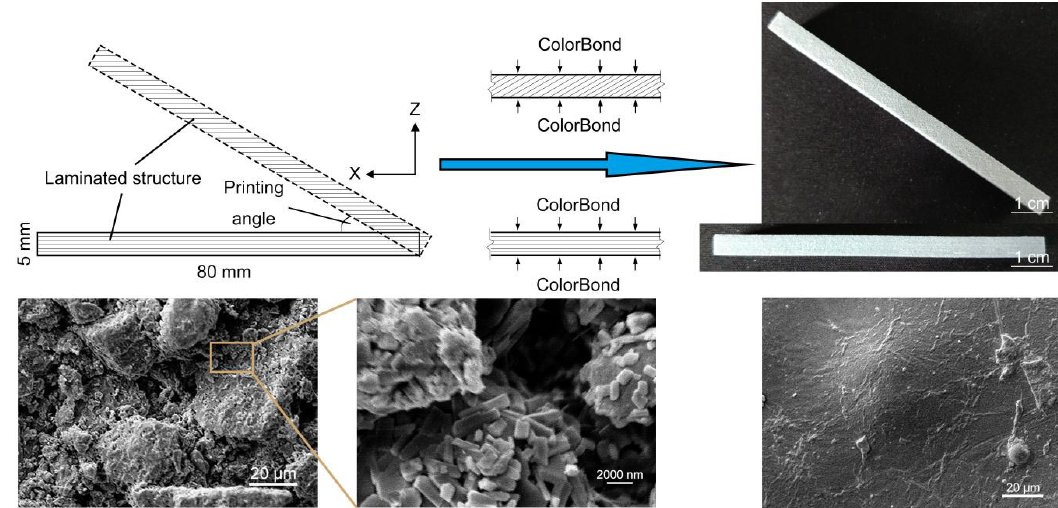
Figure 4. Dissimilarities of laminated structures and permeating process of the specimens printed at different angles, and characterization of surface appearance before and after impregnation.